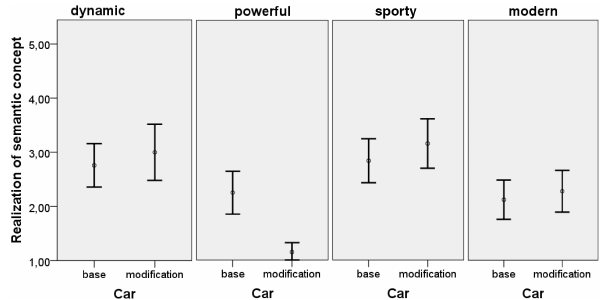
Figure 2. 95% confidence interval – articulated evaluation of the realization of semantic